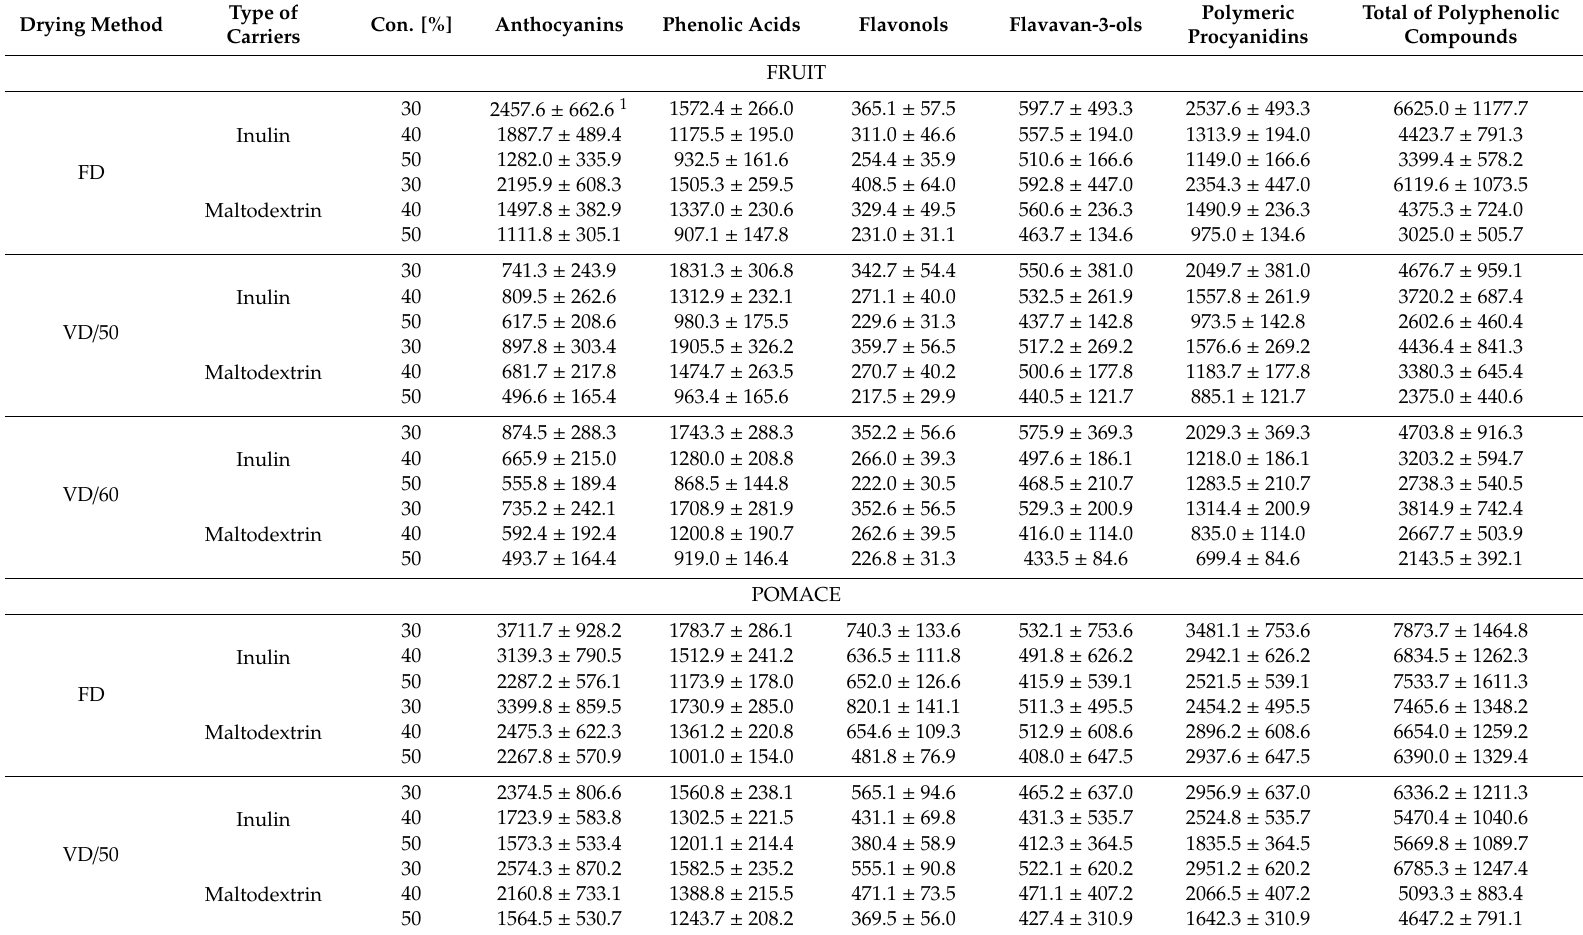
Table 1. The sum of anthocyanins, phenolic acids, flavan-3-ols, polymeric procyanidins, and total polyphenolic compounds [mg / 100 g d.m.] in the fruit, juice, and pomace powders made form Saskatoon